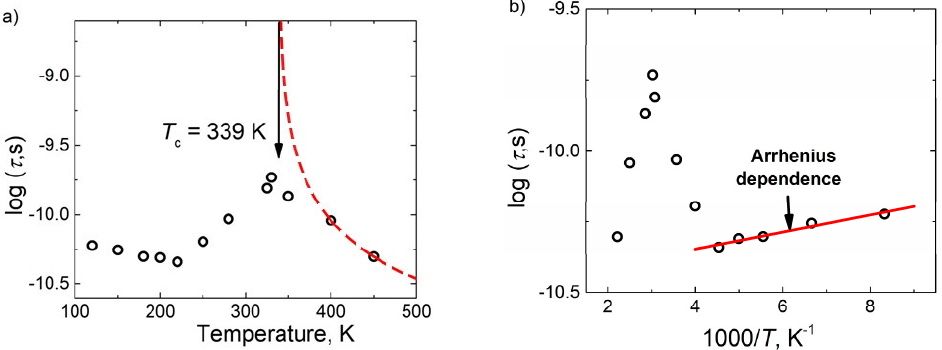
Figure 7. Temperature dependences of most probable relaxation time in linear temperature scale ( a ) and in reciprocal temperature scale ( b ).